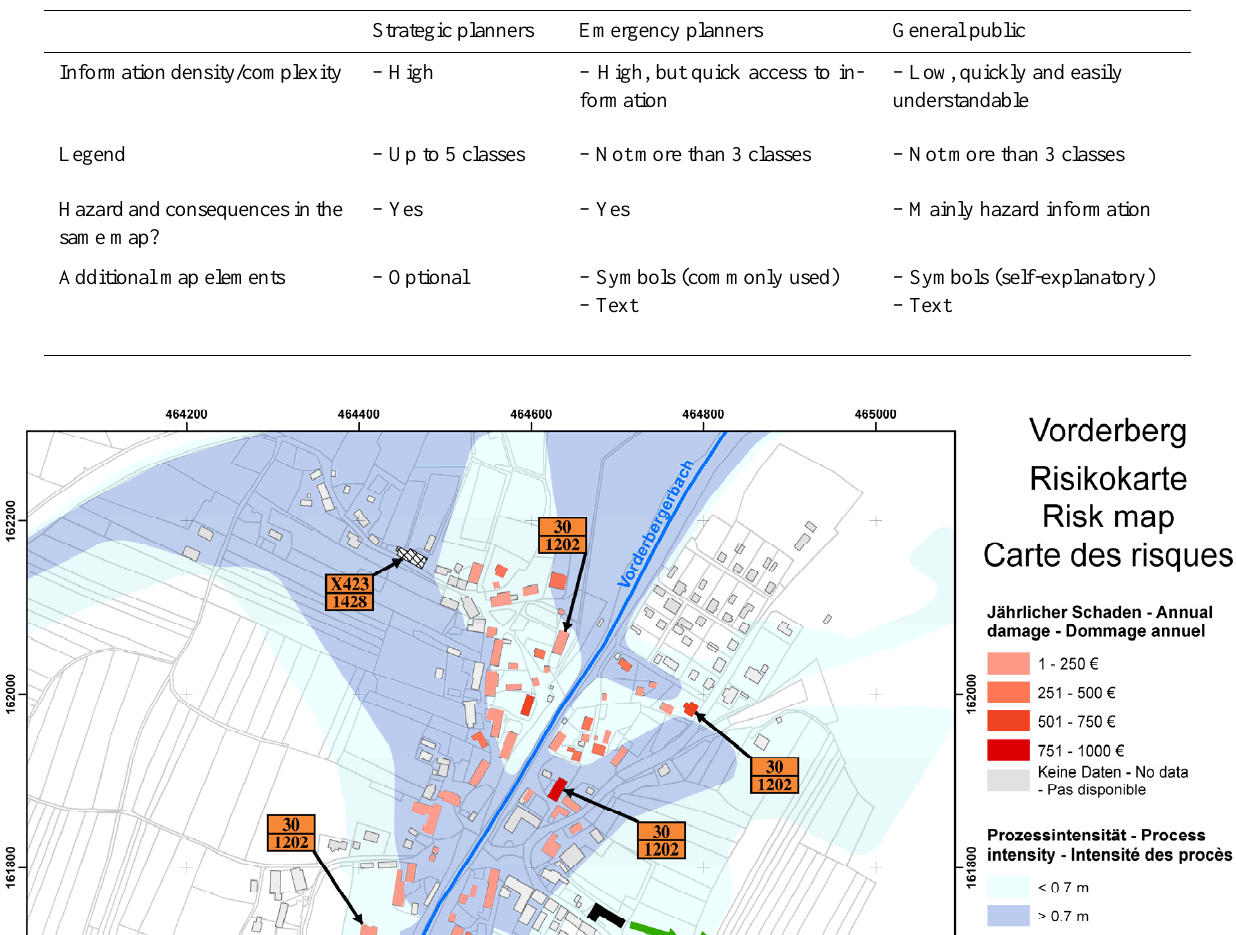
Table 4. Recommendations for visualisation.